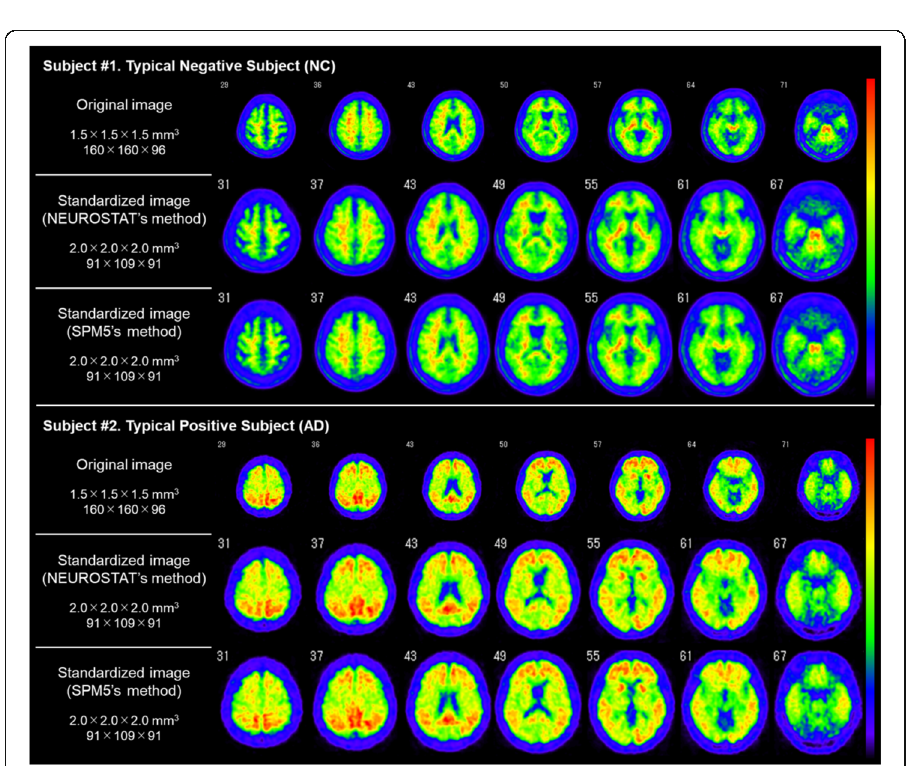
Fig. 3 Original images and the standardized images of typical negative and positive cases. From top to bottom, the original image, a standardized image using NEUROSTAT's method, and a standardized image using SPM5 ’ s